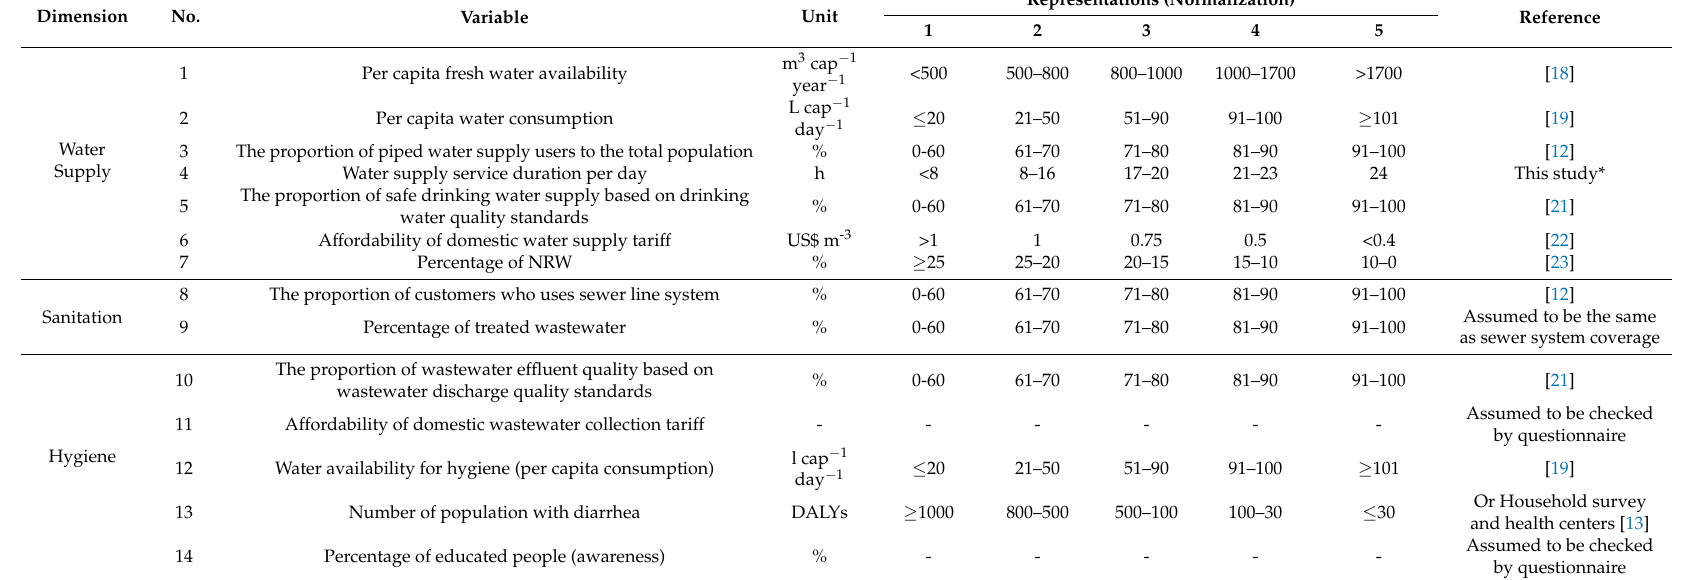
Table 2. Representation of variable scores in relation to the 1–5 scale adopted for this